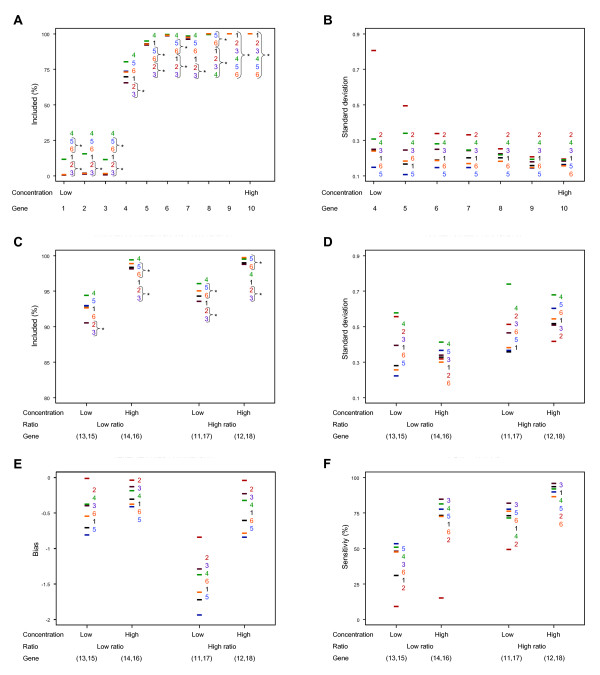
Description of individual genes for selectednormalizations. Six measures are presented: the percentage of NDE-genes included1 in the statistical analysis (6A), the overall standard deviation of the NDE-genes (6B), the percentage of DE-genes included1 in the statistical analysis (6C), the overall standard deviation of the DE-genes (6D), the reflected bias of the DE-genes (6E), and the sensitivity of the DE-genes (6F). Details of the genes (1–18) are found in Figure 2. In 6C-6F, genes with the same magnitude of regulation are presented together. The analyses are marked with different numbers: 80.I.1 (1), 80.II.1 (2), 80.II.64 (3), 80.V.1 (4), CM.I.l (5) and CM.II.l (6). A star indicates that values are equal. 1) A gene was included in the statistical analysis if at least one of the arrays was able to generate an observation of the desired log-ratio. In addition, analyses that used partial filtration did not include genes for which all arrays generated so-called not-found spots.